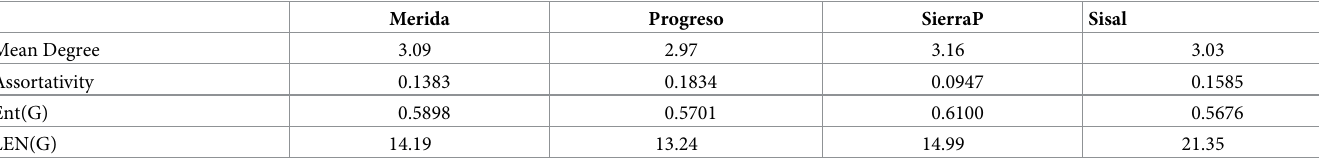
Table 5. Results for the networks generated by the averages of the months in 2015 and 2016 per